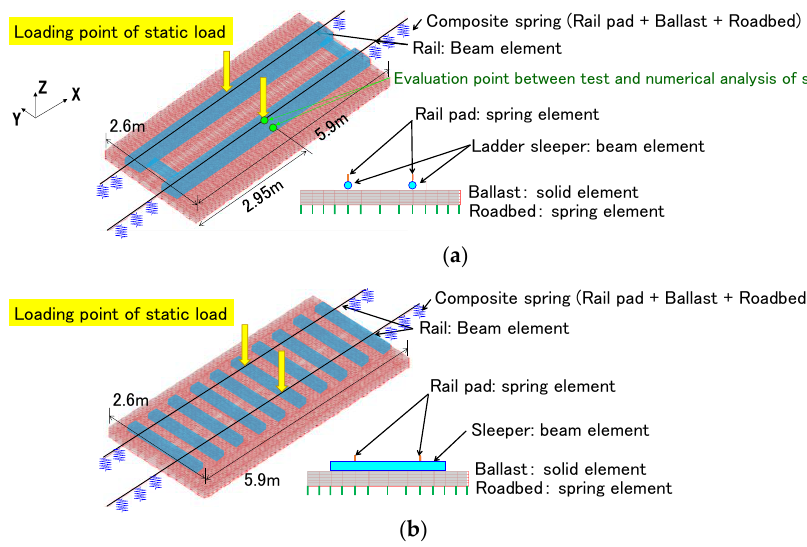
Figure 11. Dynamic model of the track: ( a ) ballasted ladder track; ( b ) PC sleeper track.